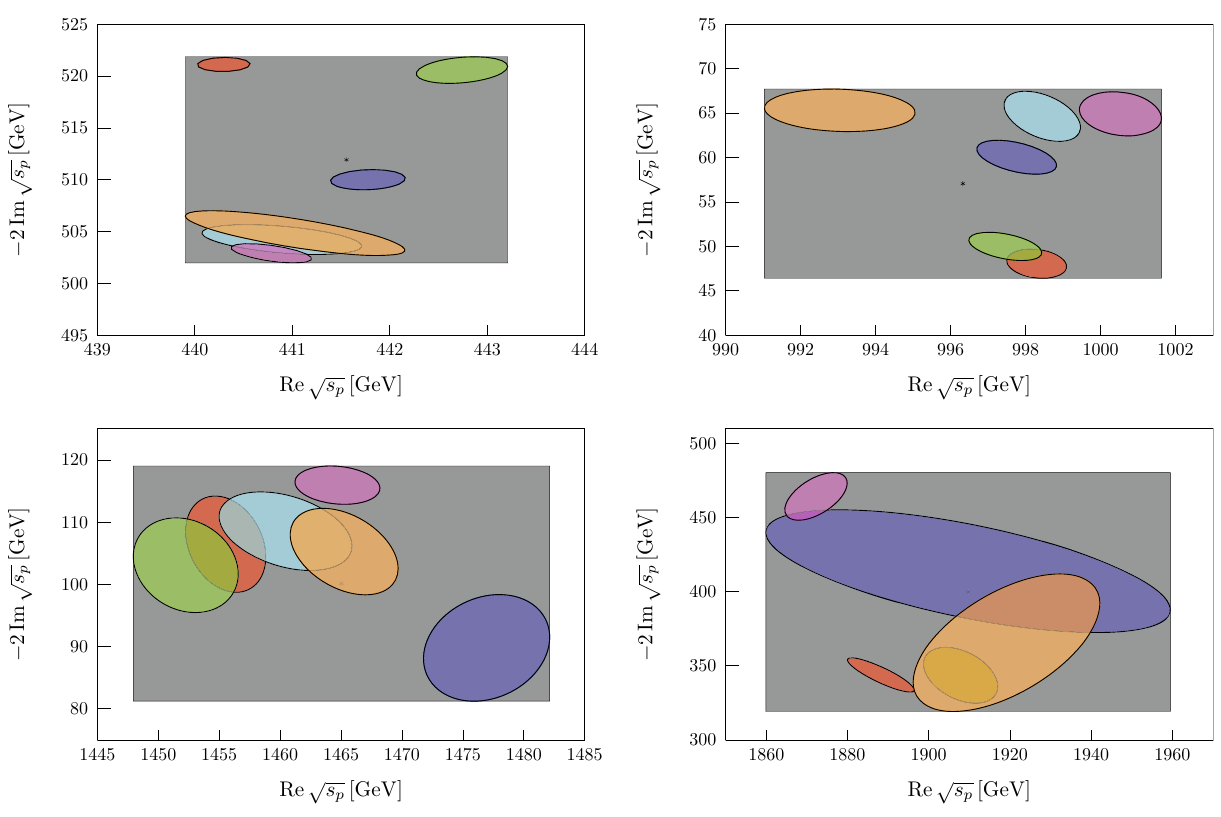
as the fits with the ρρ channel with Fit 1 (cyan), Fit 2 (magenta), and Fit 3 (orange). The mean values are shown in